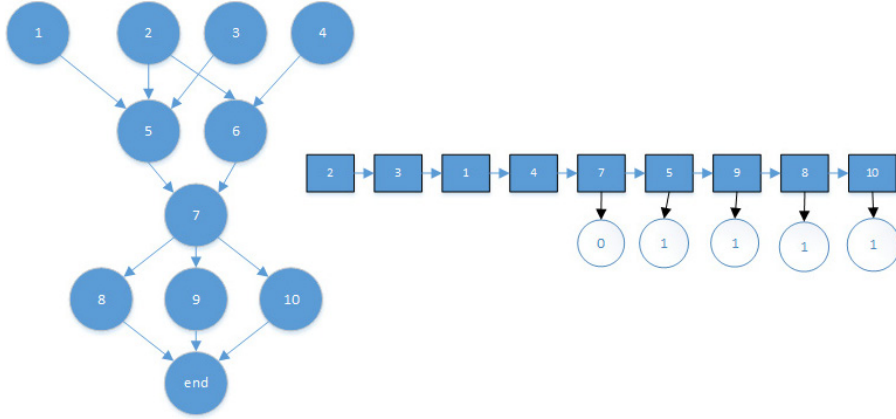
Fig. 3. Resolving